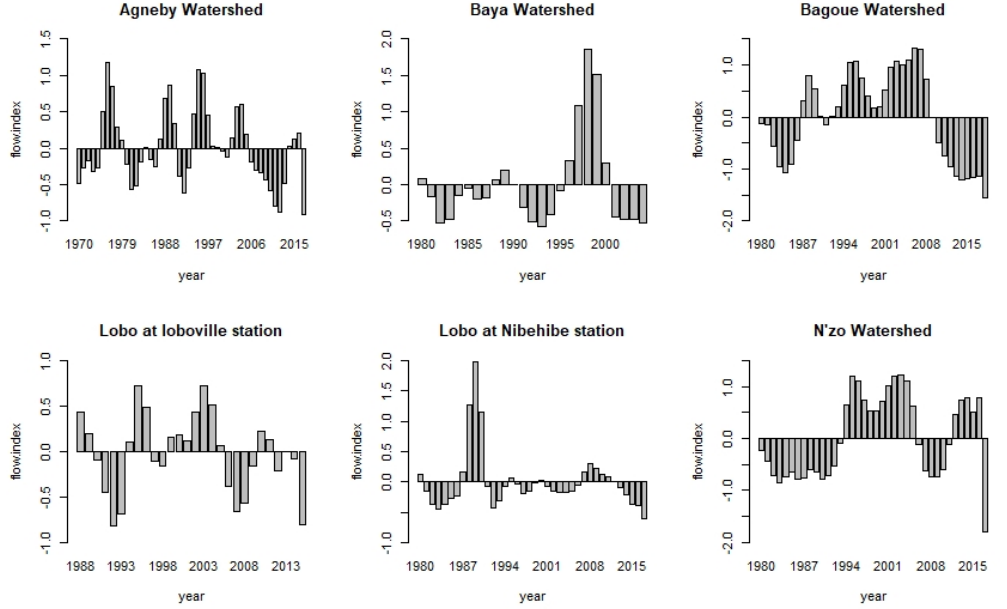
Figure 2. Interannual variations in discharge in each watershed using the non-recursive low-pass Hanning filter of order 2 . Table 3. A trend analysis of flood index (Qmaxan, VCX30, and POT) and low-discharge index (Qminan, QMNA, VCN7, and WFD) values in some watersheds in C ô te d’Ivoire. Trend (MMK